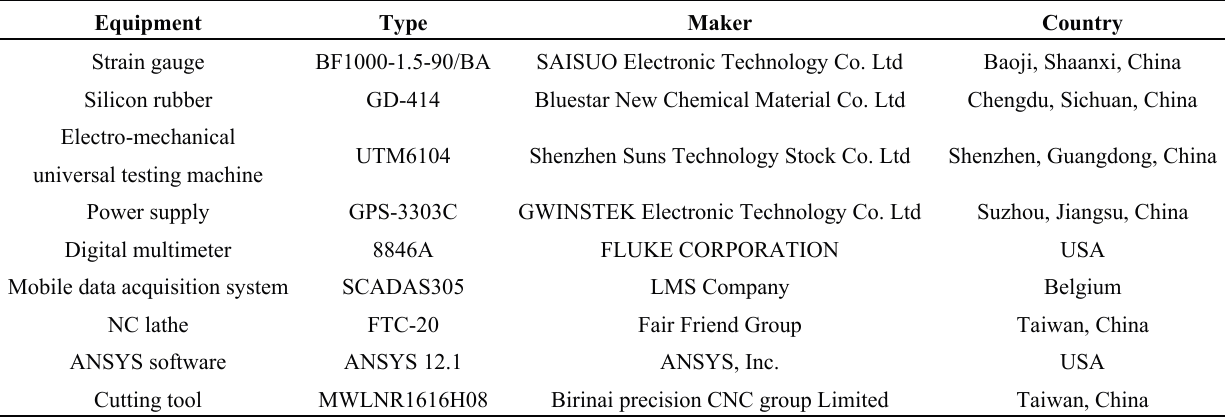
Table 2. Detail information of the software and equipment involved in this